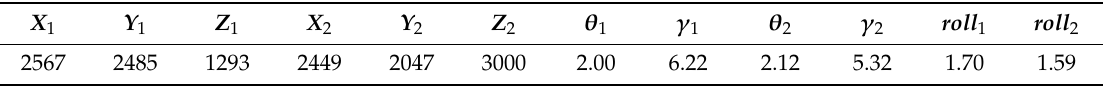
Table 10. Extrinsic parameters identified by the analysis as global optimum for the BlenSor kitchen model; Data refers to configuration with two sensors.